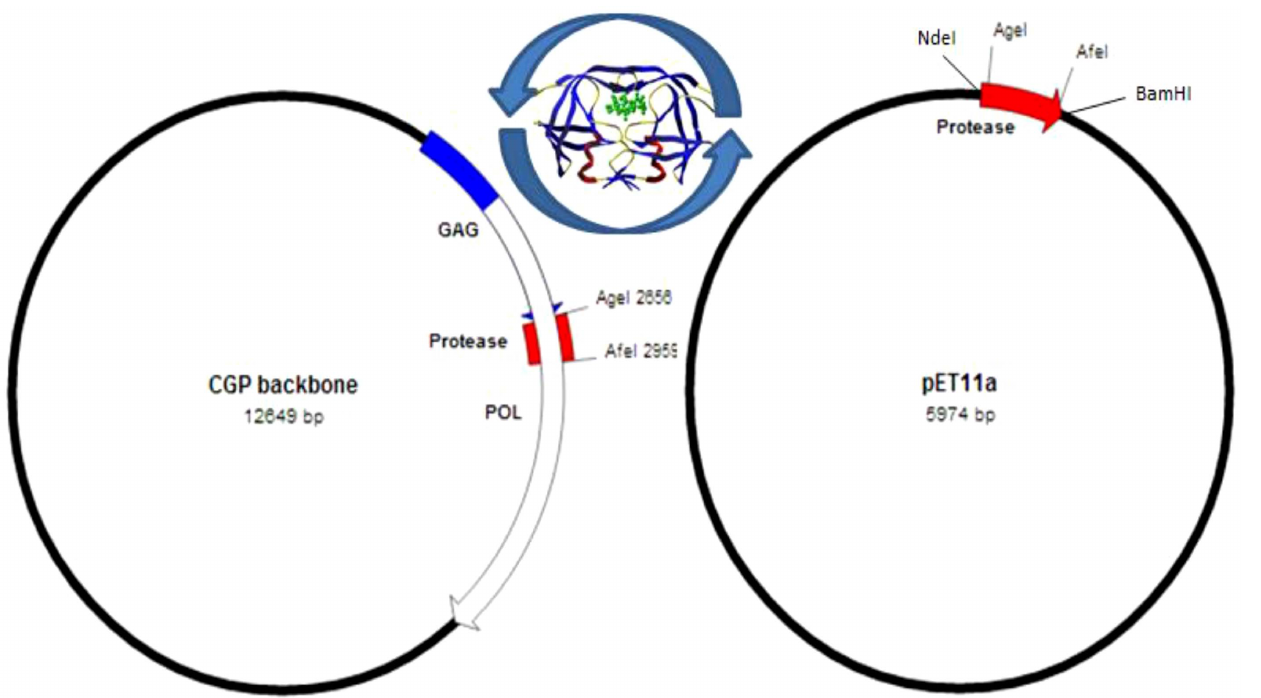
Figure 2. Schematic representation of the cassette system. HIV-2 protease can be interchanged between the lentiviral HIV-2CGP vector and the in vitro pET11a expression plasmid, utilizing the unique restriction sites. Protease sequence: P Q F S LW K R * P V V TAY I E G Q P V E V L L D T G A D D S I